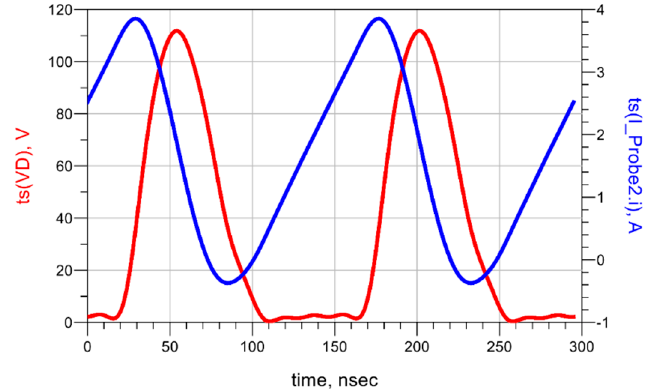
Figure 9. Transient waveforms using the EM field and RF circuit co-simulation at the drain node of the transistor.